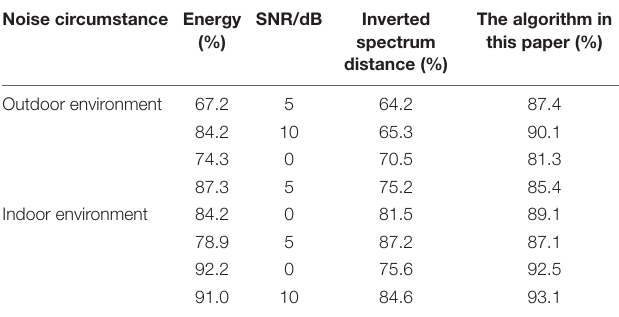
TABLE 3 | Voice signal interception accuracy.